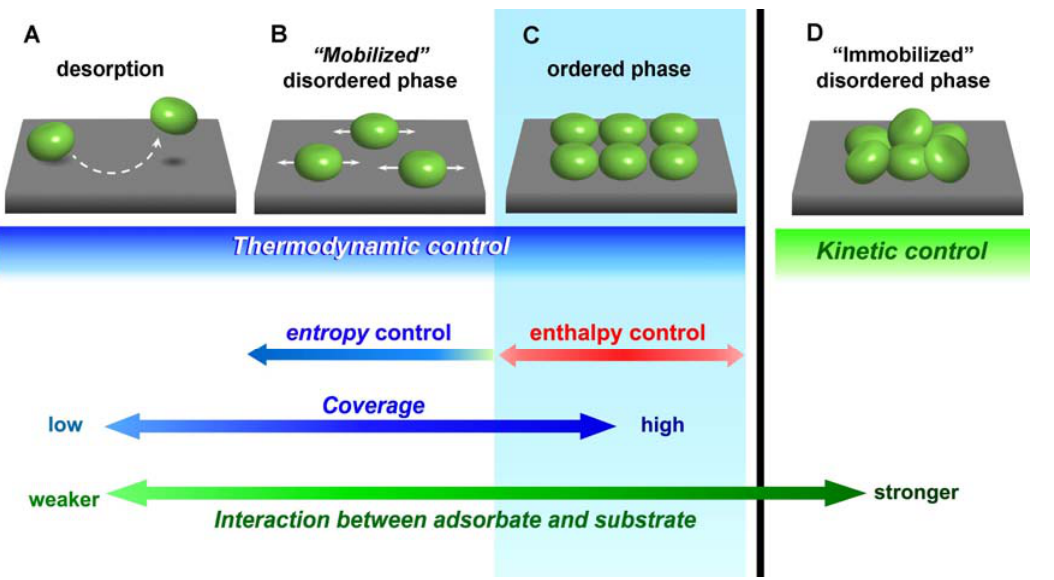
Figure 2. Four isothermal adsorption states against adsorption